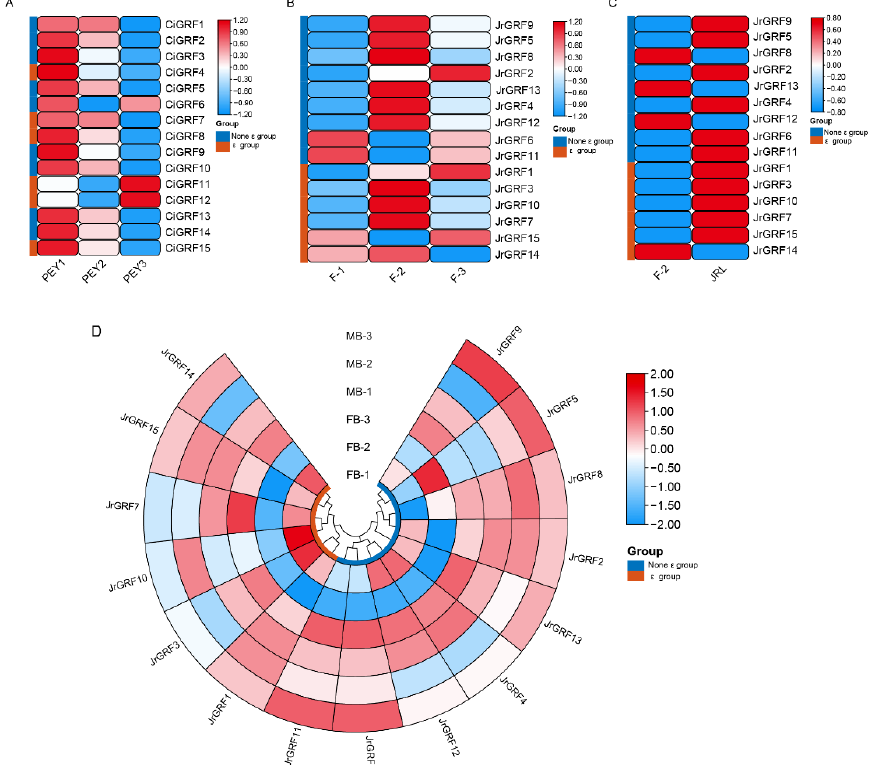
Figure 7. Expression patterns of walnut GRF genes ( CiGRFs and JrGRFs ) in flower buds and em- bryos. ( A ) Expression patterns of CiGRFs in embryonic development. ( B ) Expression patterns of JrGRFs in female flower bud differentiation of Juglans regia cv. Xinxin No.2. ( C ) JrGRFs expression in female flower buds and leaf buds of Juglans regia cv. Xinxin No.2. ( D ) Expression of JrGRFs in male and female flower buds in Juglans regia L. cv. Wen185.